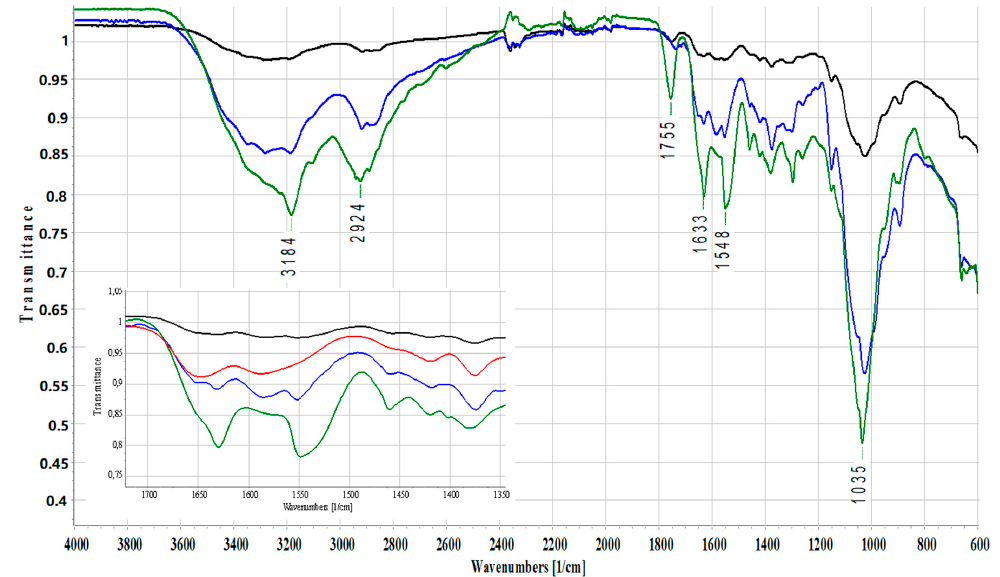
Figure 3. FTIR scan of PLGA-chitosan hybrid products of the reactions synthesized with di ff erent molar rapport of PLGA:chitosan of reaction (1) 1:5. black (2) 1:1. blue (3) 5:1. green, and (4) pure chitosan (red